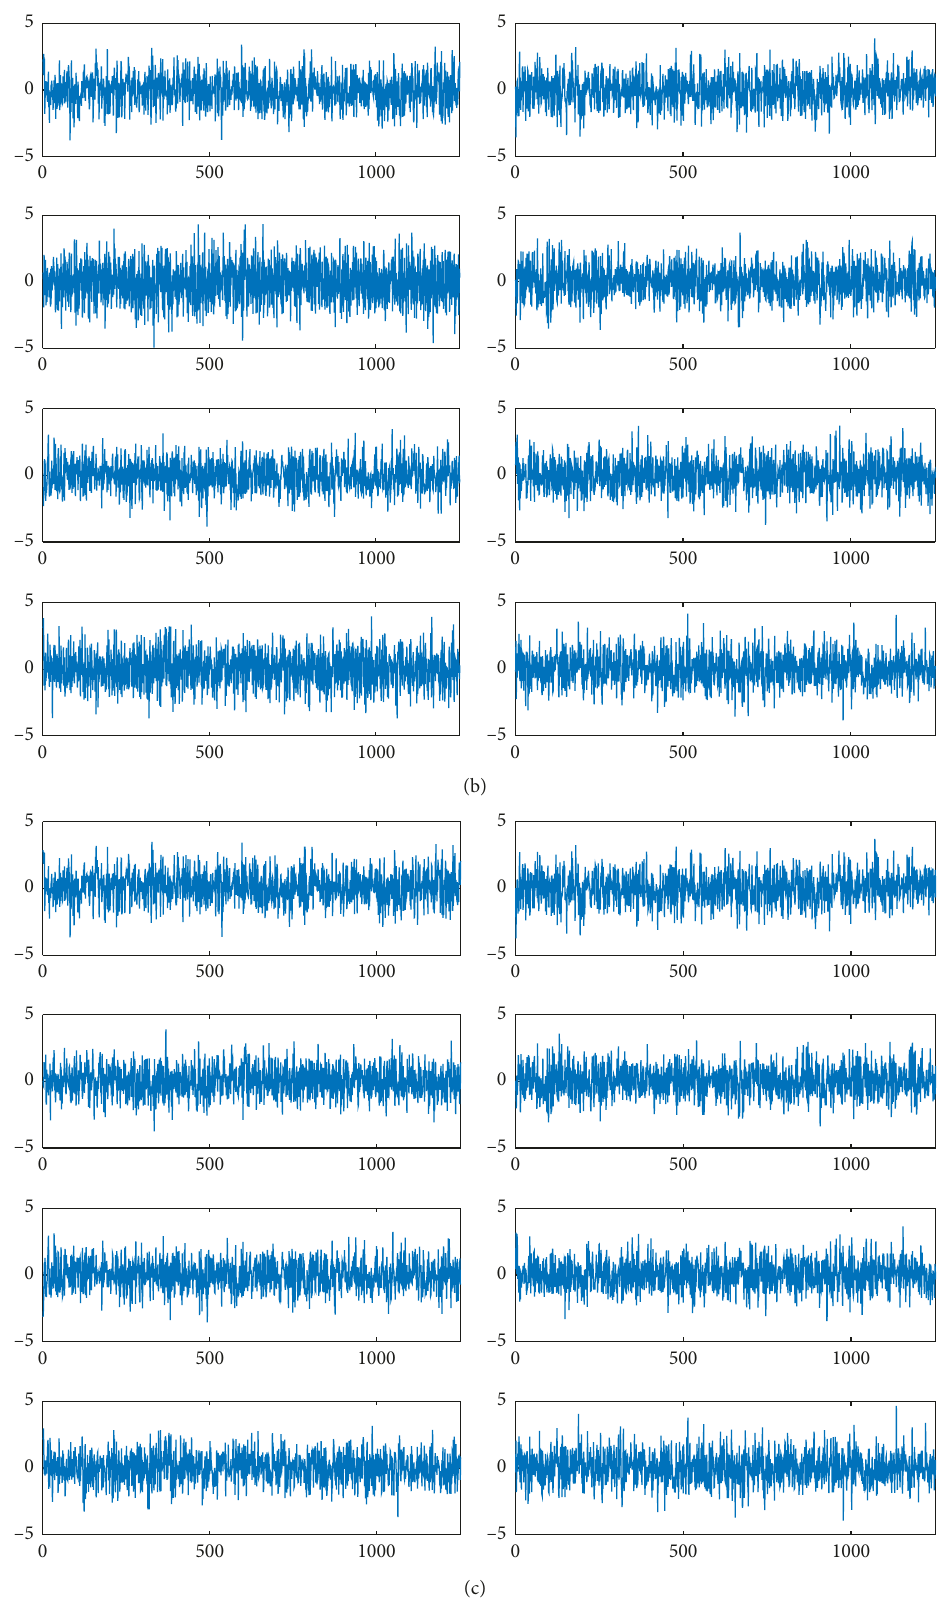
Figure 15: Response signal reconstruction coefficients of piezoelectric patches: (a) normal piezoelectric patch; (b) broken piezoelectric patch; (c) degummed piezoelectric